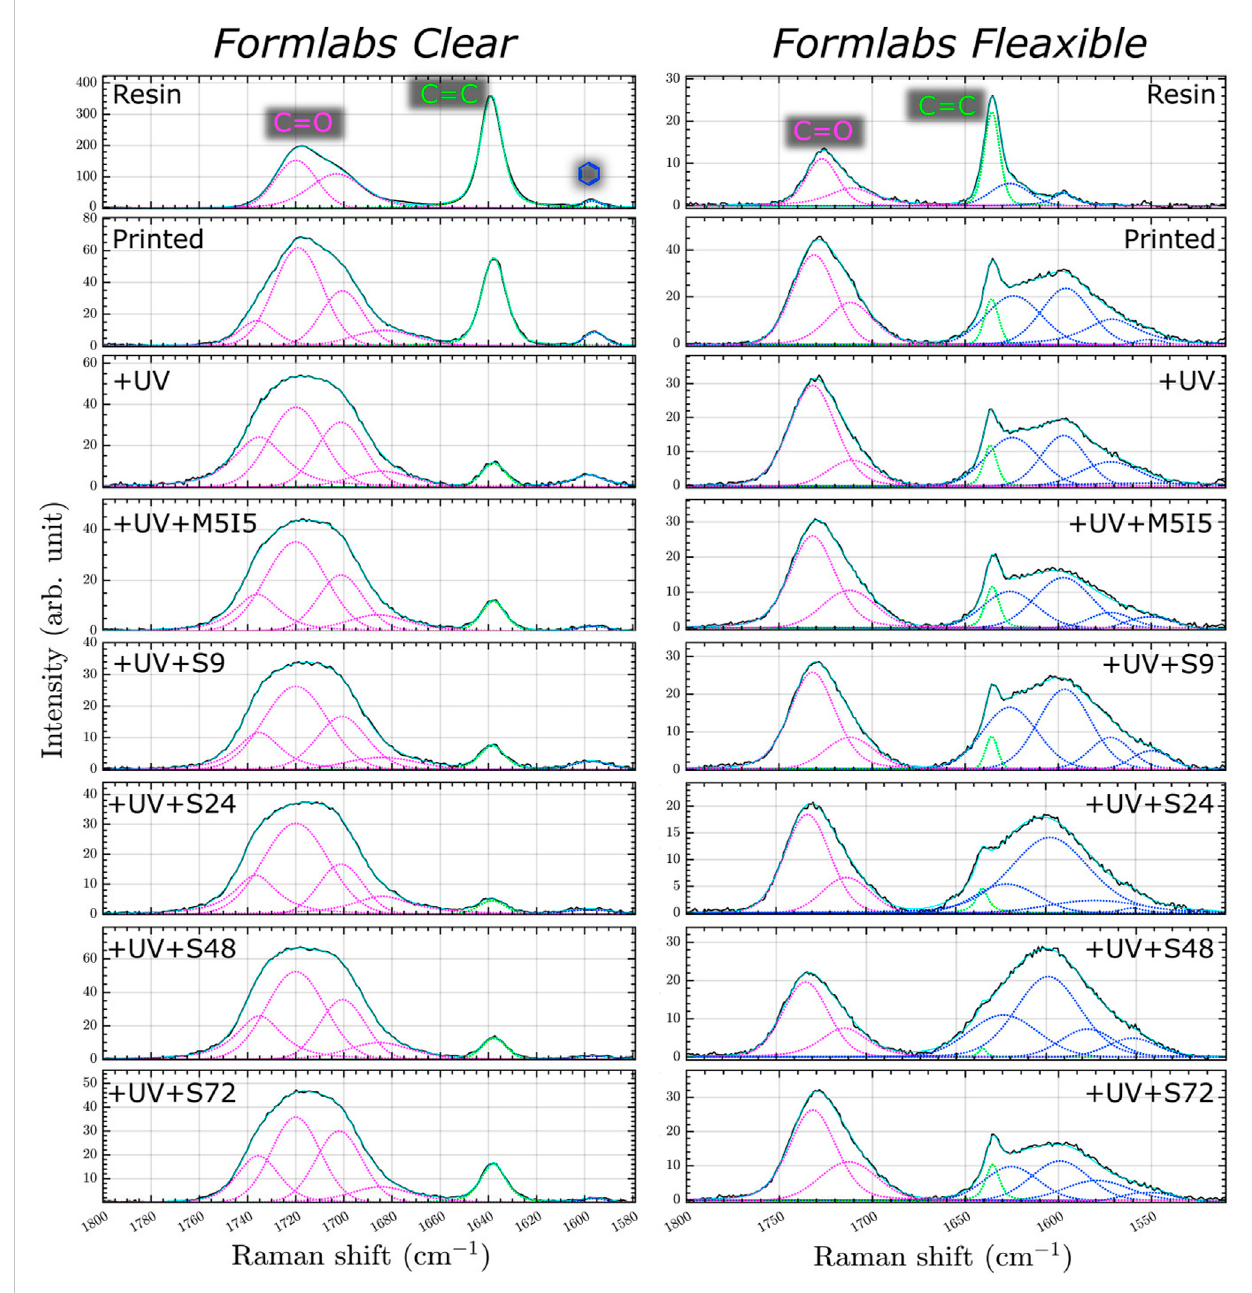
FIGURE 7 Micro Raman spectra of resin and 3D printed scaffolds: just printed, additionally UV post-cured (UV), post-cured and differently post-washed.